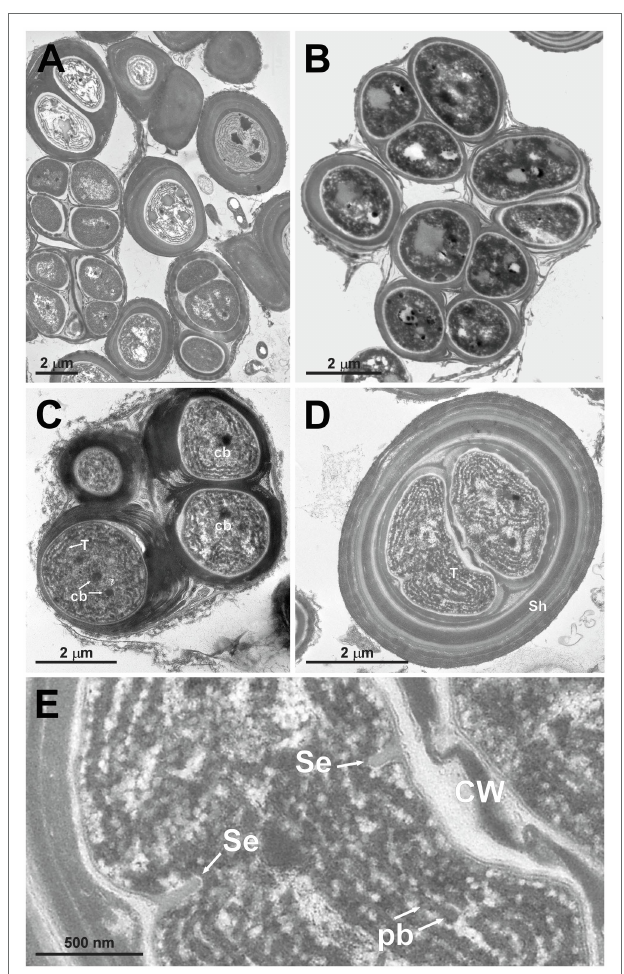
FIGURE 5 | TEM micrographs of Gloeocapsopsis dulcis sp. nov. strain AAB1. (A,B) show the diffluent shape of colonies. (C) depicts a tetrad of cells with carboxysomes (cb) and parietal thylakoid membranes (T). (D) shows a cell embedded in multiple layers of dense extracellular polymeric substances and intracellular sheaths (Sh). (E) shows a detail of (D) , depicting the cortical area with thylakoids, phycobilisomes (pb), and the incipient formation of a septum (Se). CW, cell